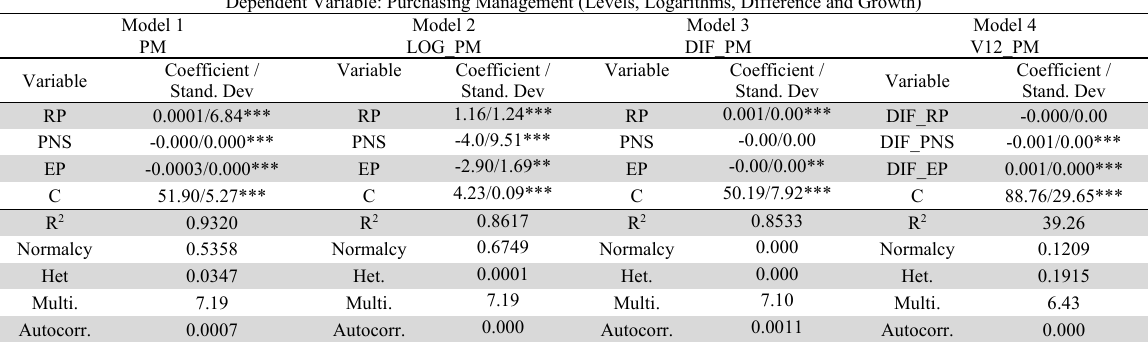
Model Specification for Purchasing Management Method: Ordinary Least Squares Dependent Variable: Purchasing Management (Levels, Logarithms, Difference and